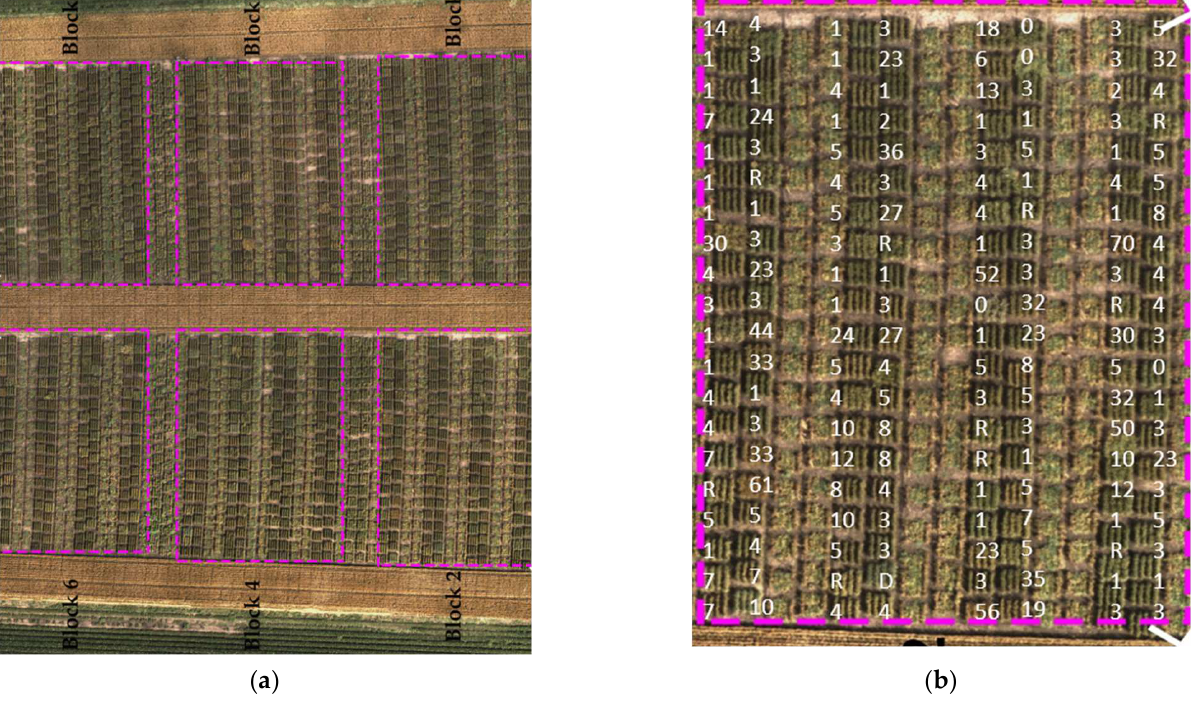
Figure 1. Top view of the field of the study in Rosemount, Minnesota: ( a ) aerial image of the entire experiment, blocks 2, 3, and 6 were inoculated, and the other blocks 1, 4, and 5 were sprayed with fungicide; ( b ) one P. graminis- inoculated block with a superimposed coefficient of infection values.